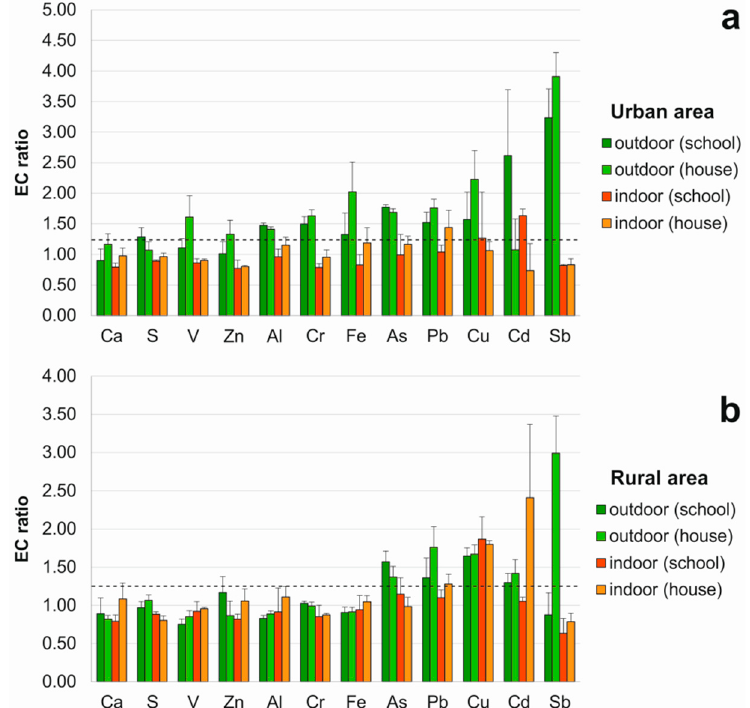
Figure 1. Exposed to Control ratios (average values in vertical bars ± standard deviation) of samples transplanted outdoors and indoors in: ( a ) urban area; ( b ) rural area. The dashed line indicates a significant accumulation (threshold EC > 1.25) (see reference [41]).